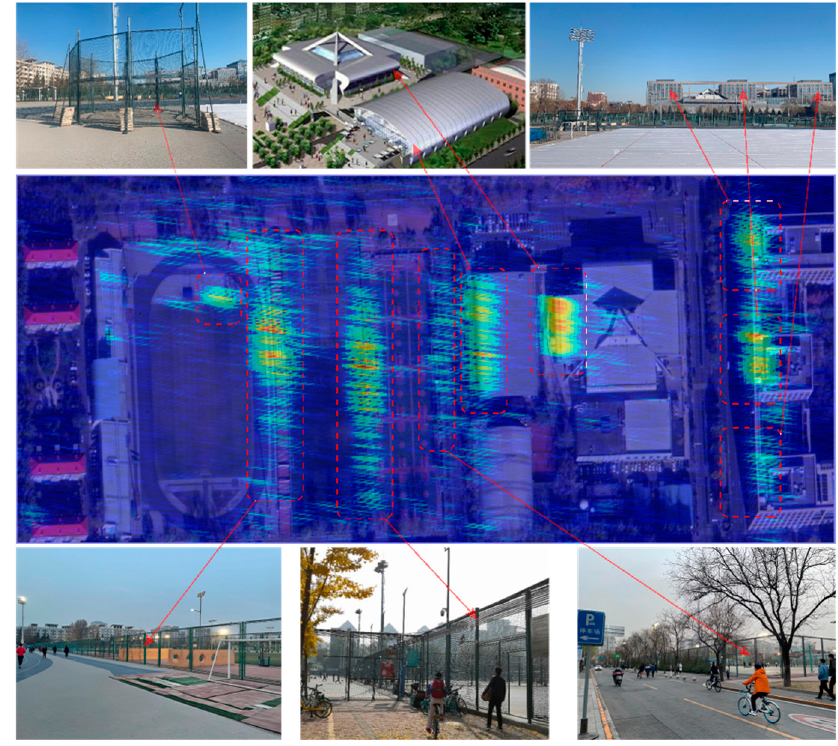
Figure 10. Comparison between the optical image and the resultant radar image.